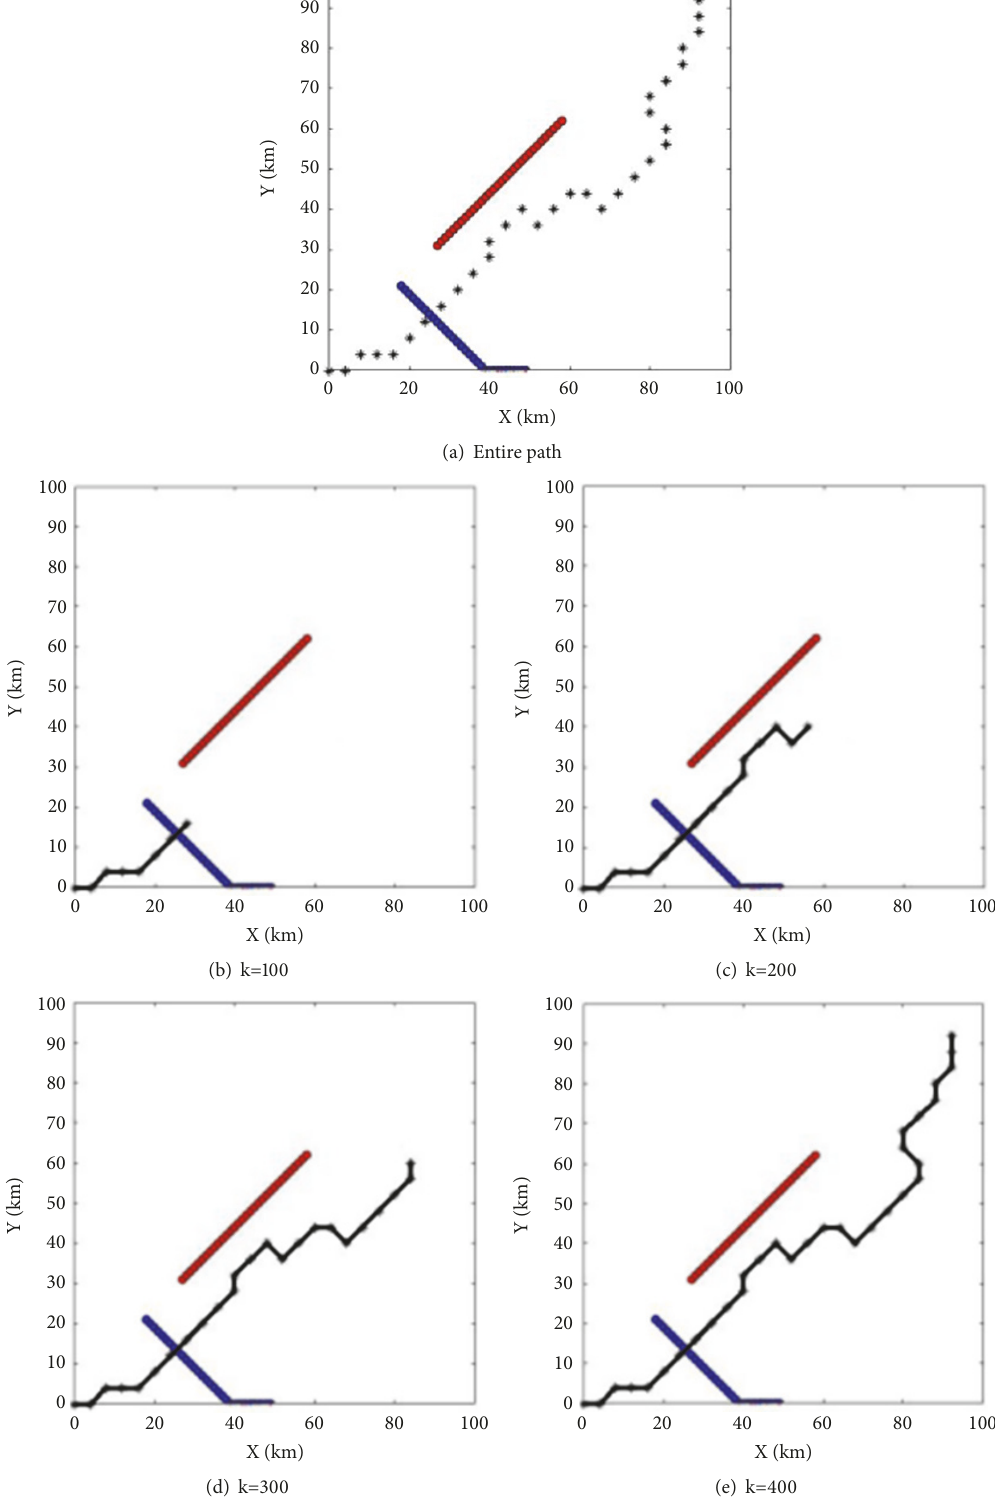
Figure 10: UAV path planning in one environment based on our proposed algorithm. And there are only mobile threats where(a) is an entire path and (b) to (e) are paths with iterations = 100, 200, 300,